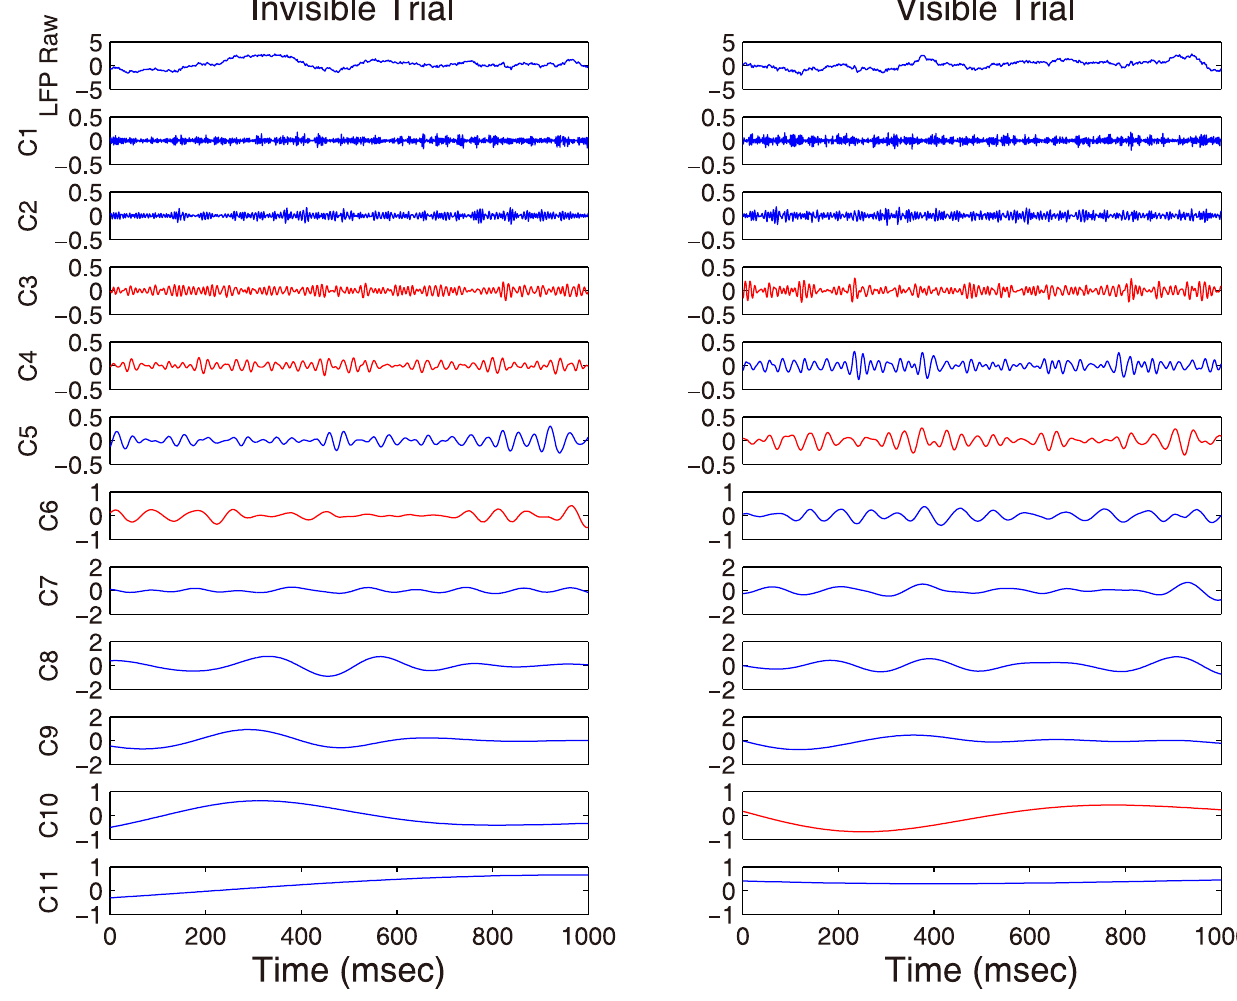
Figure 6. Examples of decomposition from two trials of LFP time series, one is from the invisible condition (Left), and another from the visible condition (Right). 0 indicates the surrounding onset. Our approach is able to identify the information-bearing IMFs, which are highlighted in red.